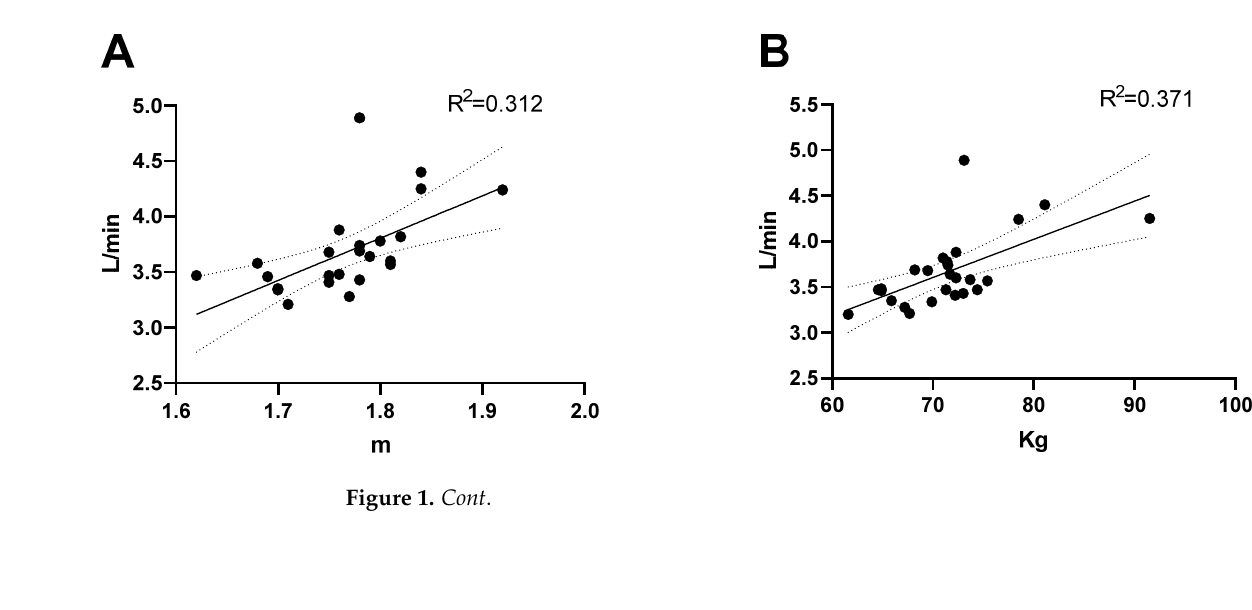
Figure 1. Linear regressions of statistically significant correlations in men soccer players. ( A ) VO 2max and stretch stature; ( B ) VO 2max and body mass; ( C ) VO 2max and muscle weight; ( D ) maximum time in the incremental test and skinfolds; ( E ) maximum time in the incremental test and fat percentage; ( F ) maximum speed in the maximum incremental test and skinfolds; ( G ) maximum speed in the maximum incremental test and fat percentage; VO 2max : maximum oxygen uptake.